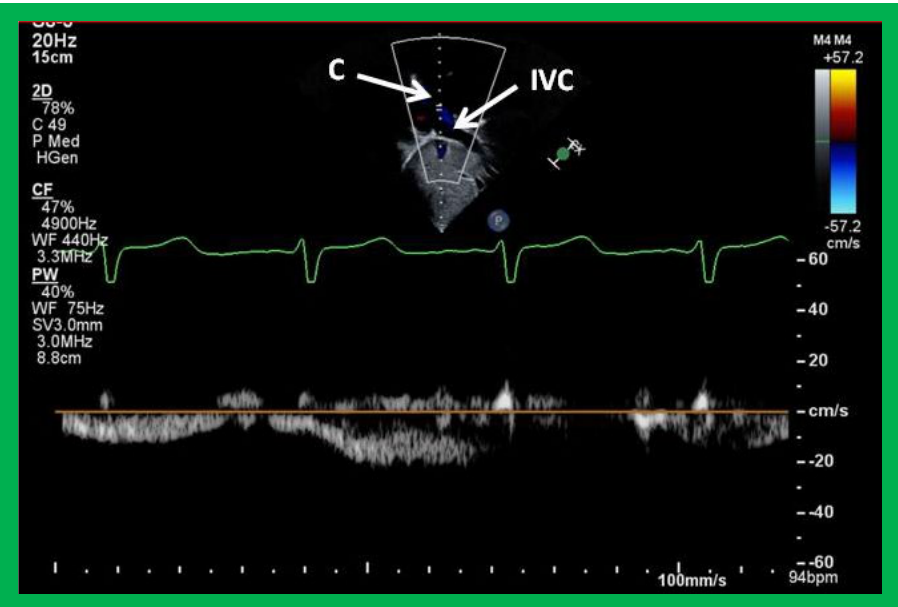
Figure 48. Selected video frames from subcostal view demonstrating connection between the infe- rior vena cava (IVC) and the conduit by 2D ( A ) and color flow imaging ( B ); note that the IVC to conduit (C) connection is wide open.